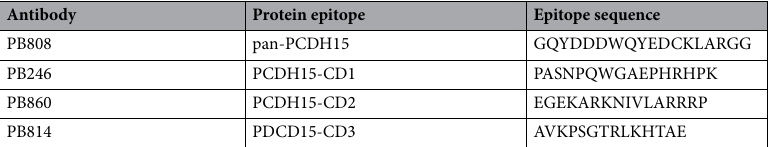
Table 1. Custom made polyclonal anti PCDH15 antibodies used in this study. The name, specific PCDH15 isoform recognized by these antibodies and the protein peptide used to generate the rabbit anti-PCDH15 antibodies are